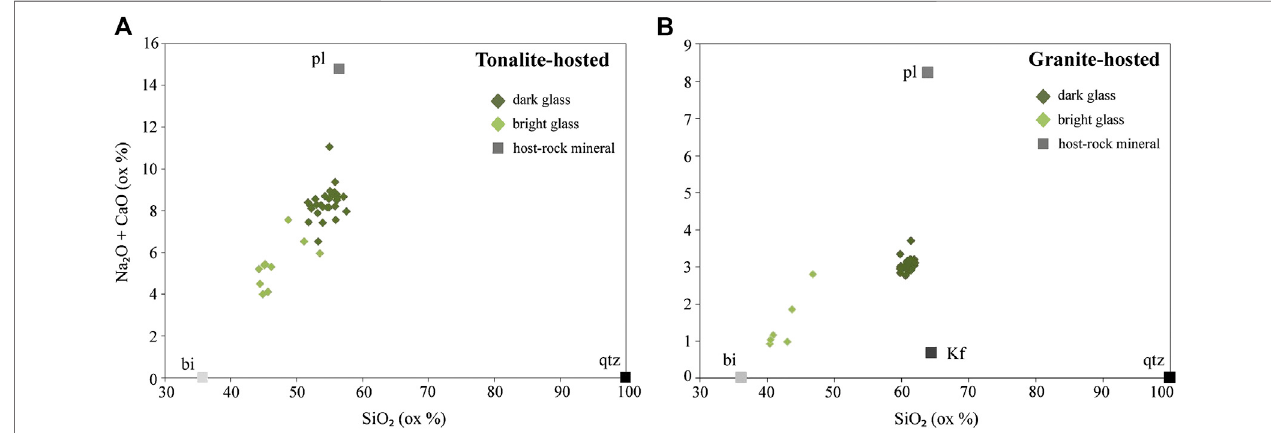
FIGURE 7 | NaO 2 +CaO vs. SiO 2 diagrams representing point analyses of bright glass (light green diamond) and dark glass (dark green diamond) for (A) tonalite- hosted samples and (B) granite-hosted samples. Squares represents host rock compositions.